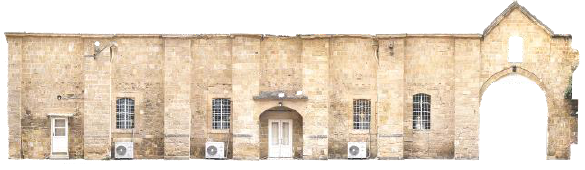
Figure 12. South elevation orthoimage